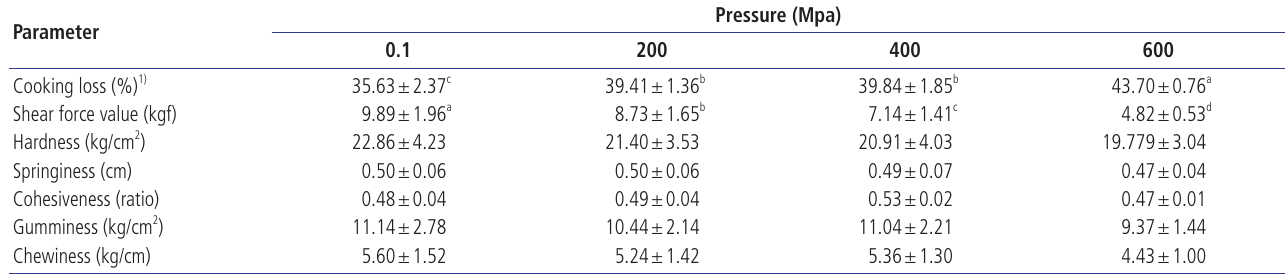
Table 1. Cooking loss, shear force value and texture profile of DFD strip loin subjected to different levels of pressure Parameter